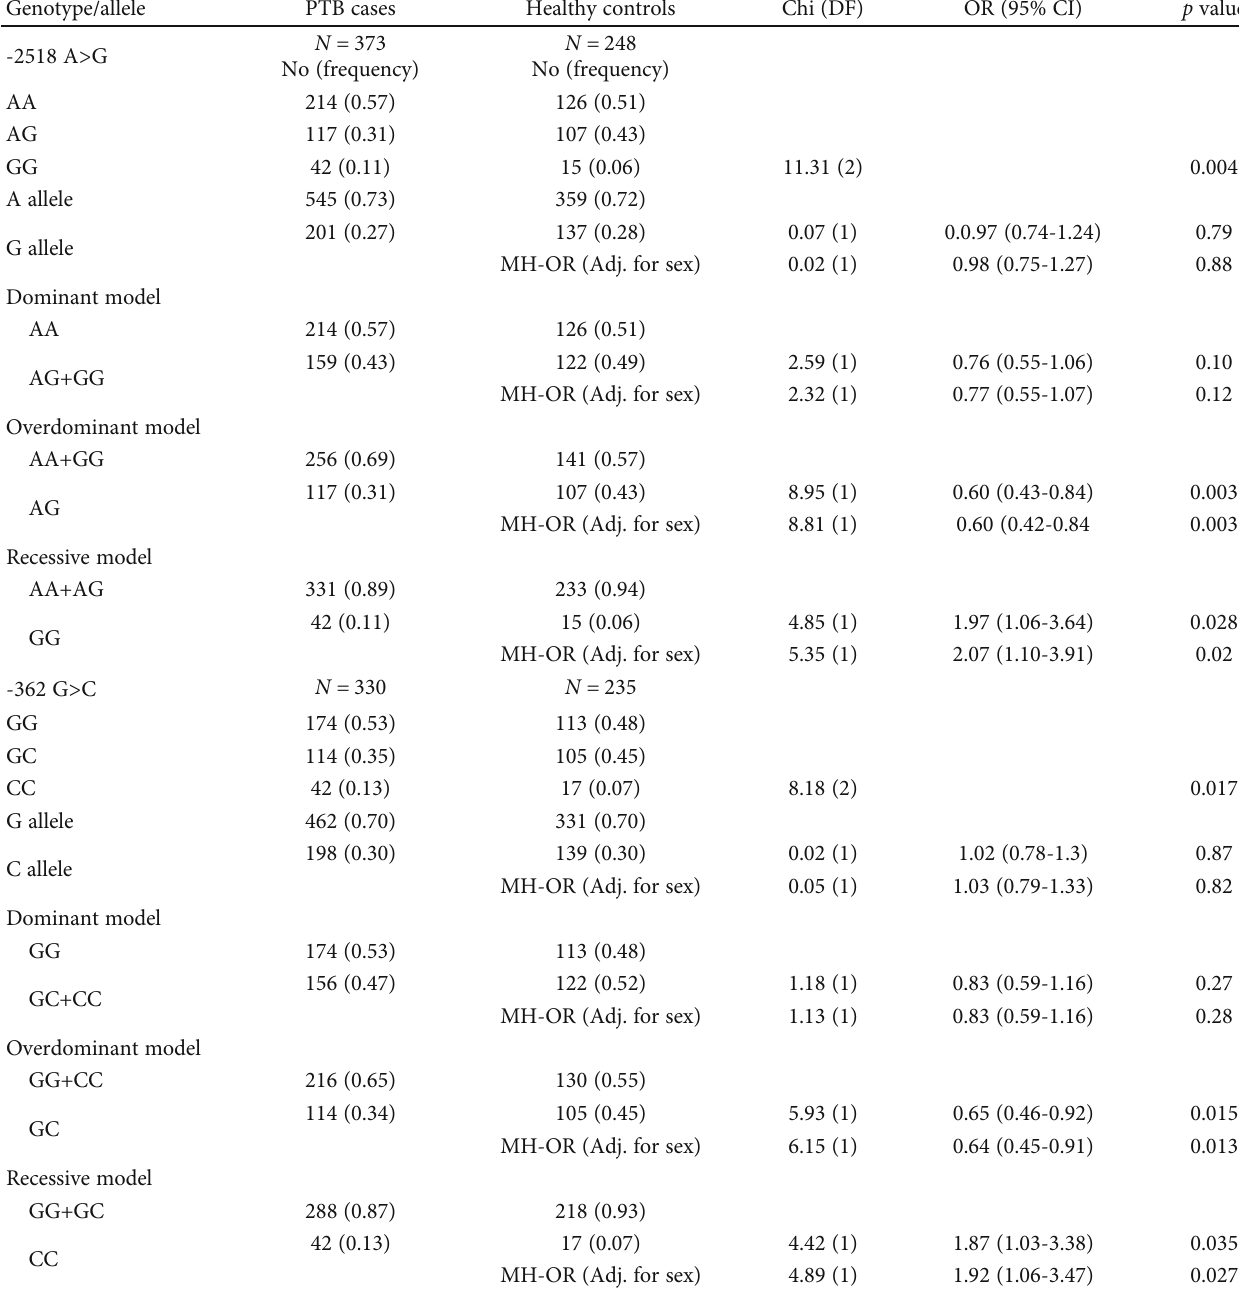
Table 2: Genotype analysis of CCL2-2518 A > G and-362 G > C polymorphisms in PTB cases and healthy control.